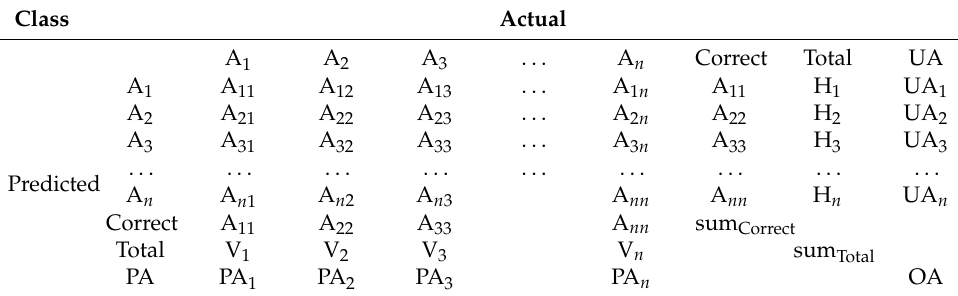
Table 5. Principles of the confusion matrix calculation. Class Actual A 1 A 2